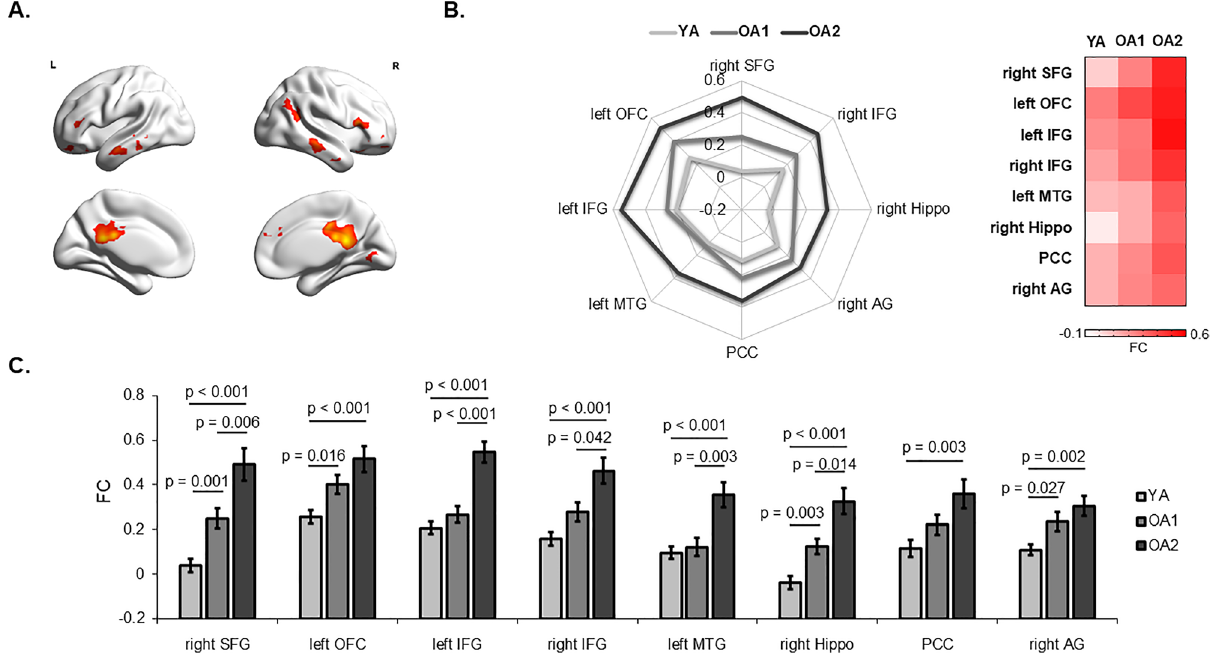
motion. The functional connectivity of multiple brain regions was significantly changed in the two old groups, including the PFC, temporal and parietal lobe. ( B ) The radar map showed the pattern of putamen connectivity in the YA, OA1, and OA2 groups. Relative to young adults, the connectivity pattern was similar in the OA1 group, but largely changed in the OA2 group. ( C ) The peak values of connectivity strength within the significant regions were extracted and plotted for the three groups (Bonferroni corrected p < 0.05). Abbreviations: AG, angular gyrus; Hippo, hippocampus; MNI, Montreal Neurological Institute; IFG, inferior frontal gyrus; MTG,